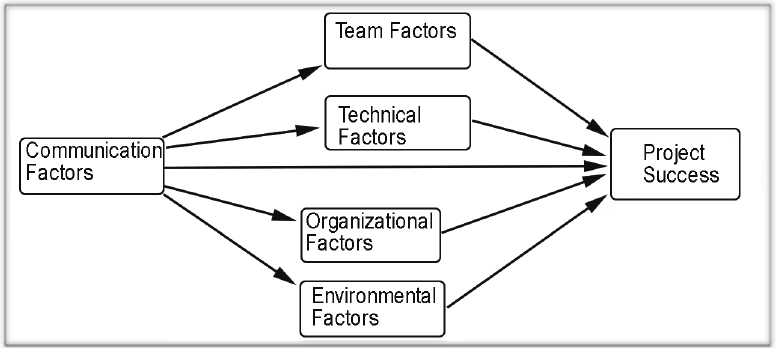
Figure 1. The research